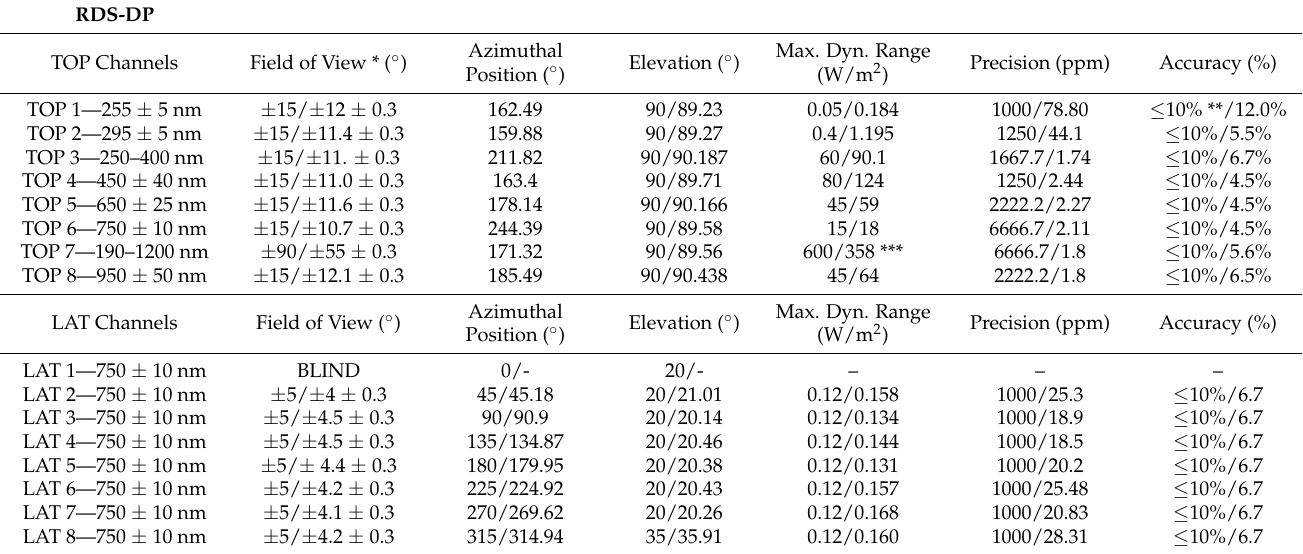
Table 2. RDS-DP FM performance for the warm case at normal incidence (designed result).